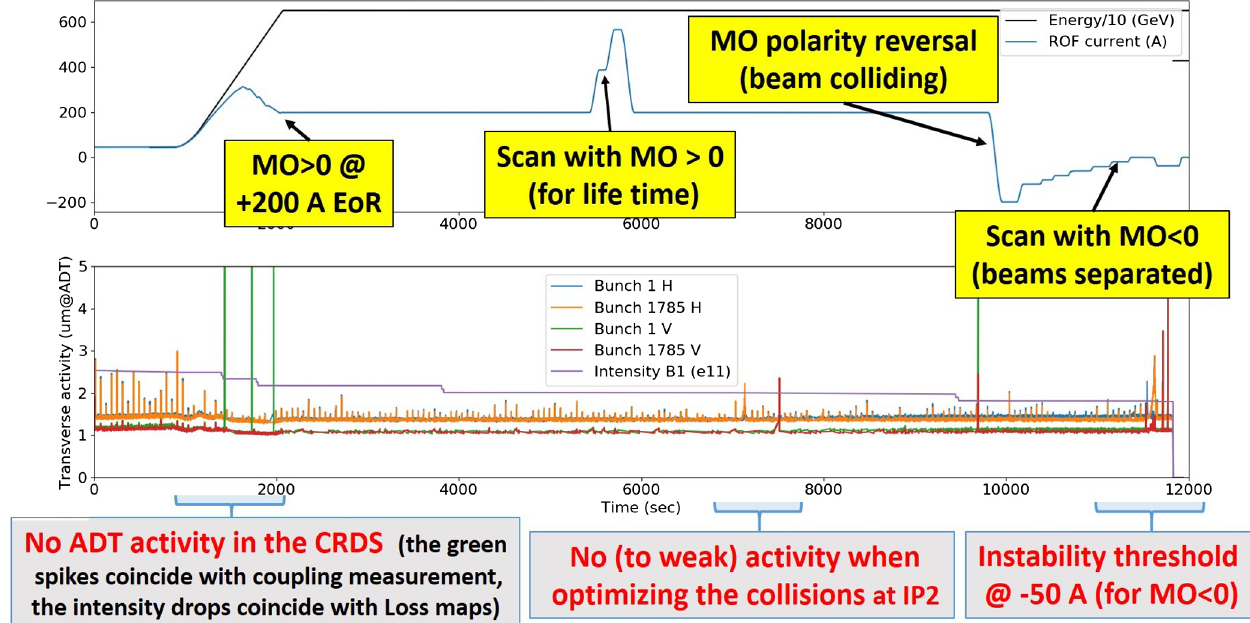
FIG. 8. 2018 ATS MD: MO ramp function (in the case of positive polarity), Beam 1 activity observation in the ramp, i.e., turn by turn oscillation amplitude at a dedicated highly sensitive pick-up nearby the transverse damper (ADT), and measurement of the MO threshold at 6.5 TeV with negative polarity ( ∼ 1 . 1 × 10 11 p = b). For this measurement, the machine was filled with a series of pilot bunches ( ∼ 6 – 7 × 10 9 p = b) for loss maps measurements, and two nominal bunches ( ∼ 1 . 0 × 10 11 p = b), namely bunch 1 and 1785 for Beam 1, for the measurement of the MO instability threshold at flat top energy.